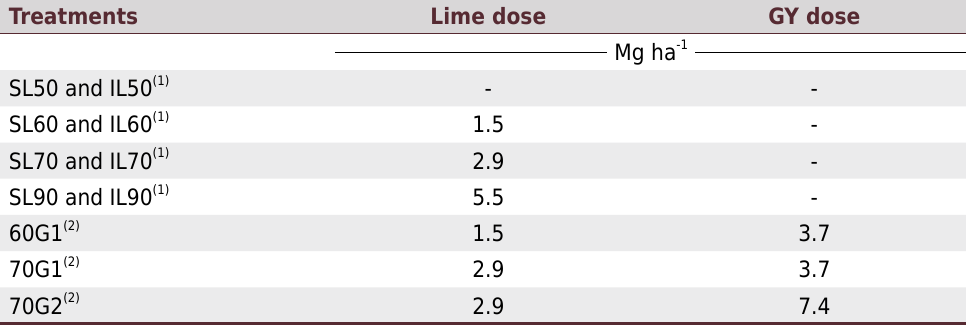
Table 2. Lime and phosphogypsum doses applied in each treatment (May 2012)